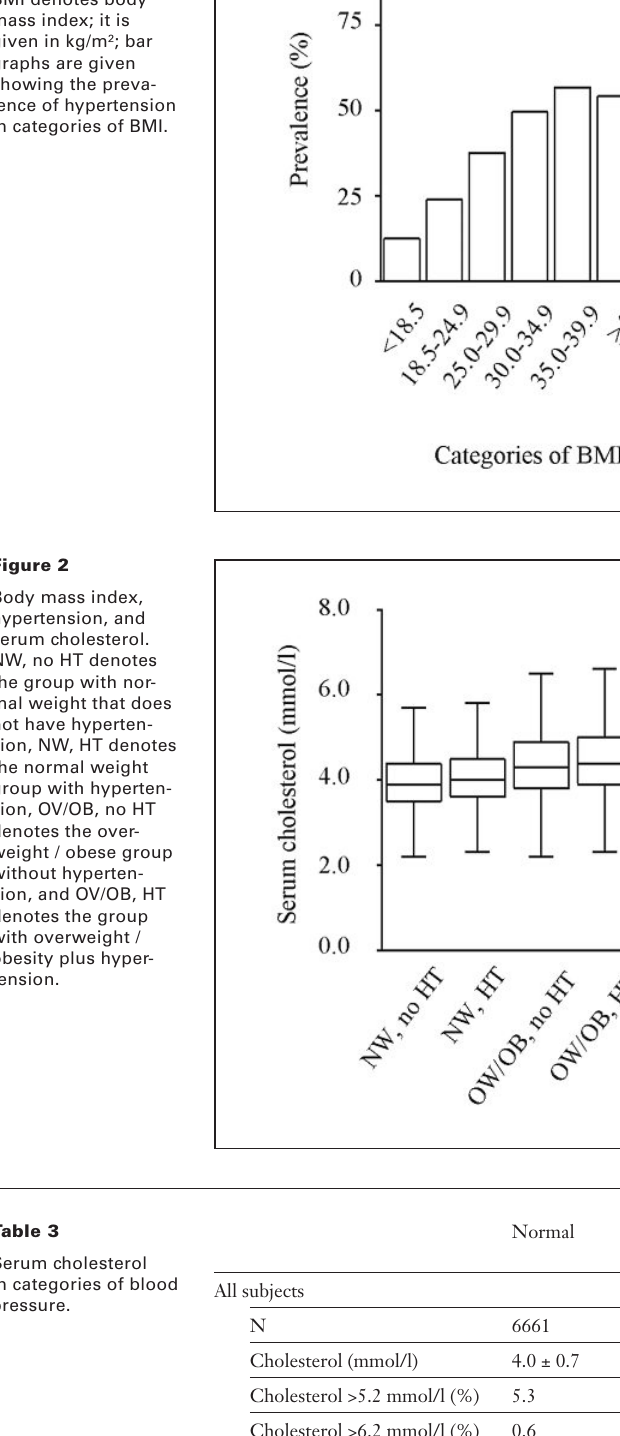
Prevalence of hyper- tension in categories of body mass index. BMI denotes body mass index; it is given in kg/m²; bar graphs are given showing the preva- lence of hypertension in categories of BMI.